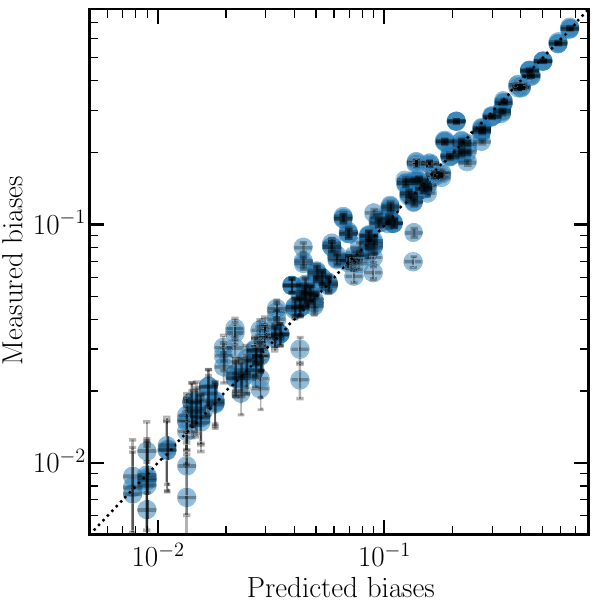
FIG. 8. Predicted [Eq. (C1)] versus found bias from estimating expectation values using Prony’s